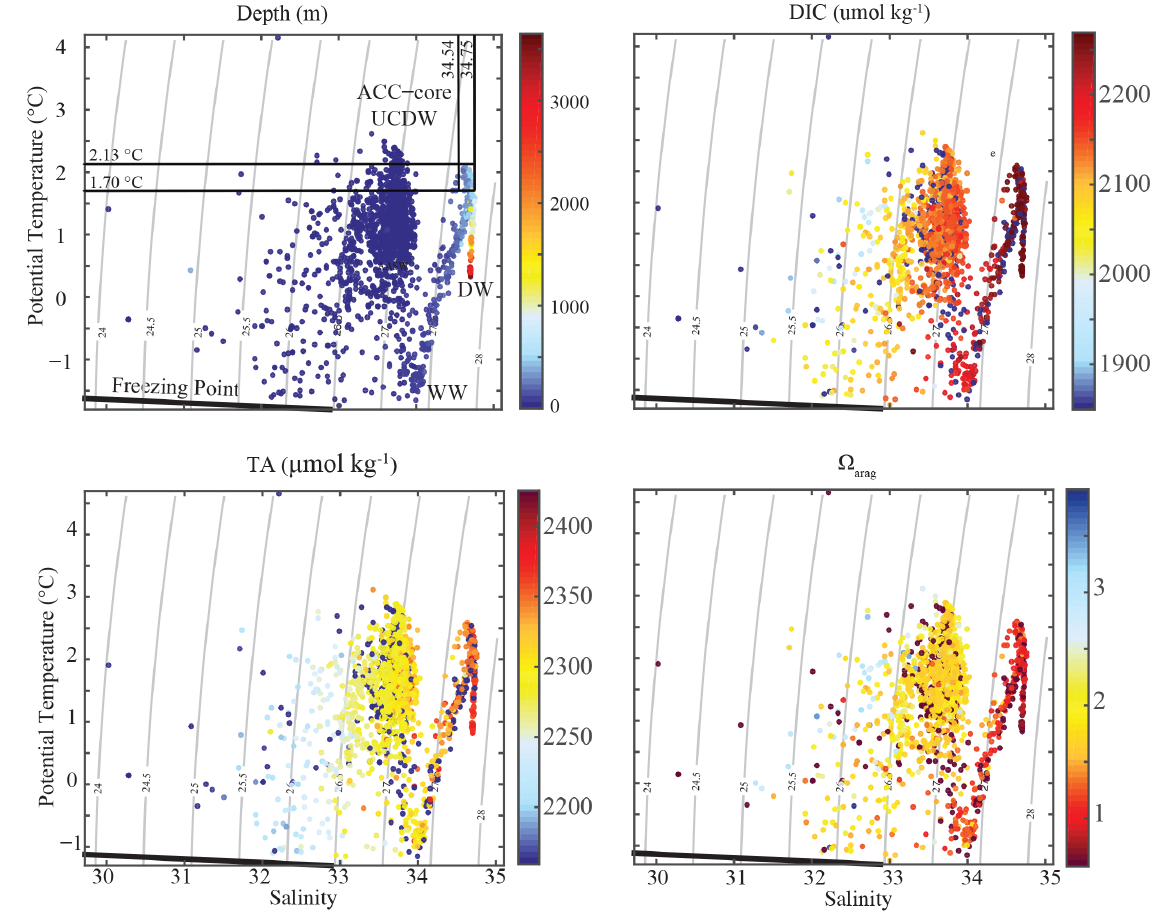
Figure A3. Scatterplots of depth and inorganic carbon chemistry superimposed on potential temperature–salinity diagrams. Shown in color are (a) depth, (b) dissolved inorganic carbon (DIC, µmolkg − 1 ) , (c) total alkalinity (TA, µmolkg − 1 ) , and (d) aragonite saturation state ( (cid:127) arag ) . The bold black line illustrates the freezing point as a function of temperature and salinity. Grey lines mark densities. Water masses are indicated and labeled in (a) : WW: winter water; AASW: Antarctic Surface Water in summer; ACC-core UCDW: Antarctic Circumpolar Current-core Upper Circumpolar Deep Water; DW: local deep water end member, following Martinson et al.